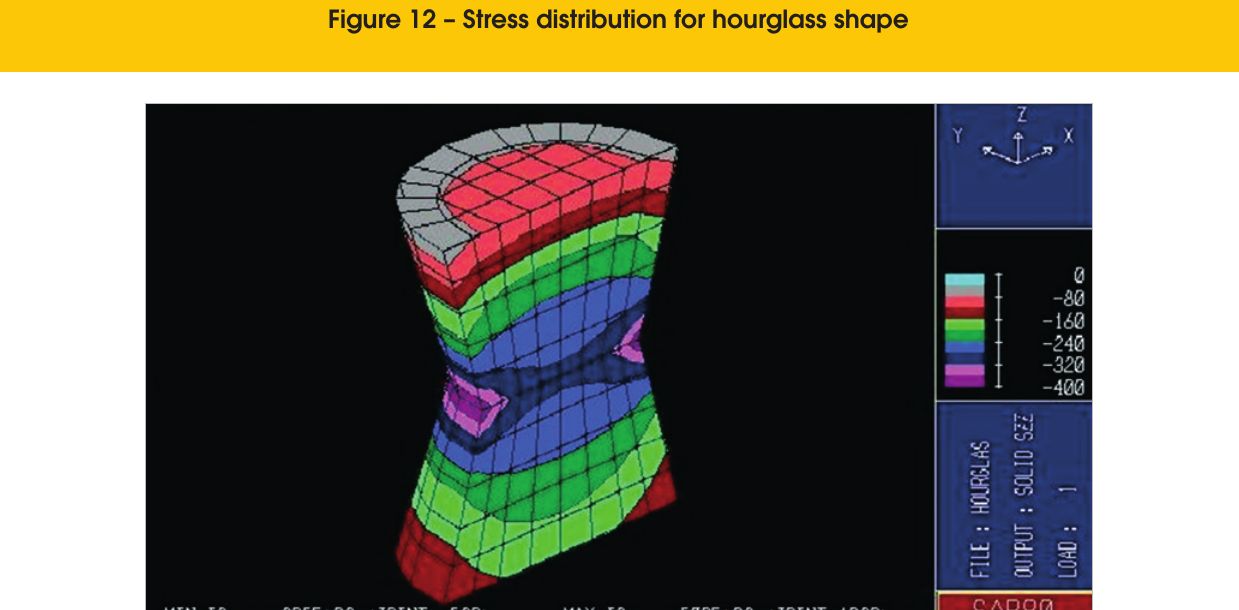
Figure 12 – Stress distribution for hourglass